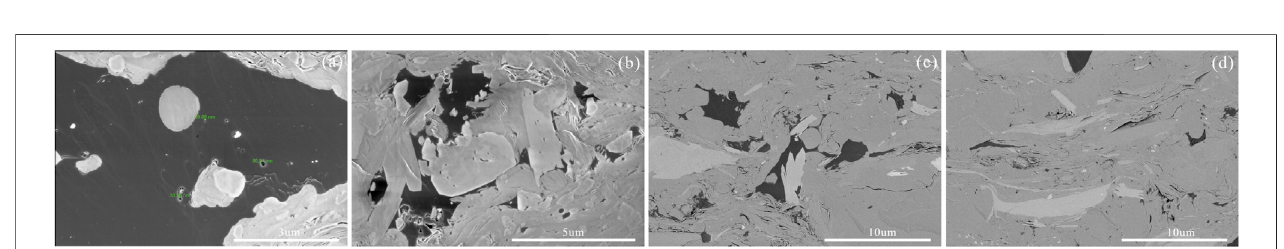
FIGURE10| SEMimagesofORAshalesamplesintheShaheziFormation. (A – D) LFS1-46. (A) Organicdebriswithlittleinternalpores; (B) bitumenwithlittleinternal pores; (C,D) a few dissolution pores inside the mineral particles, intergranular pores, and shrinkage gaps between clay minerals.